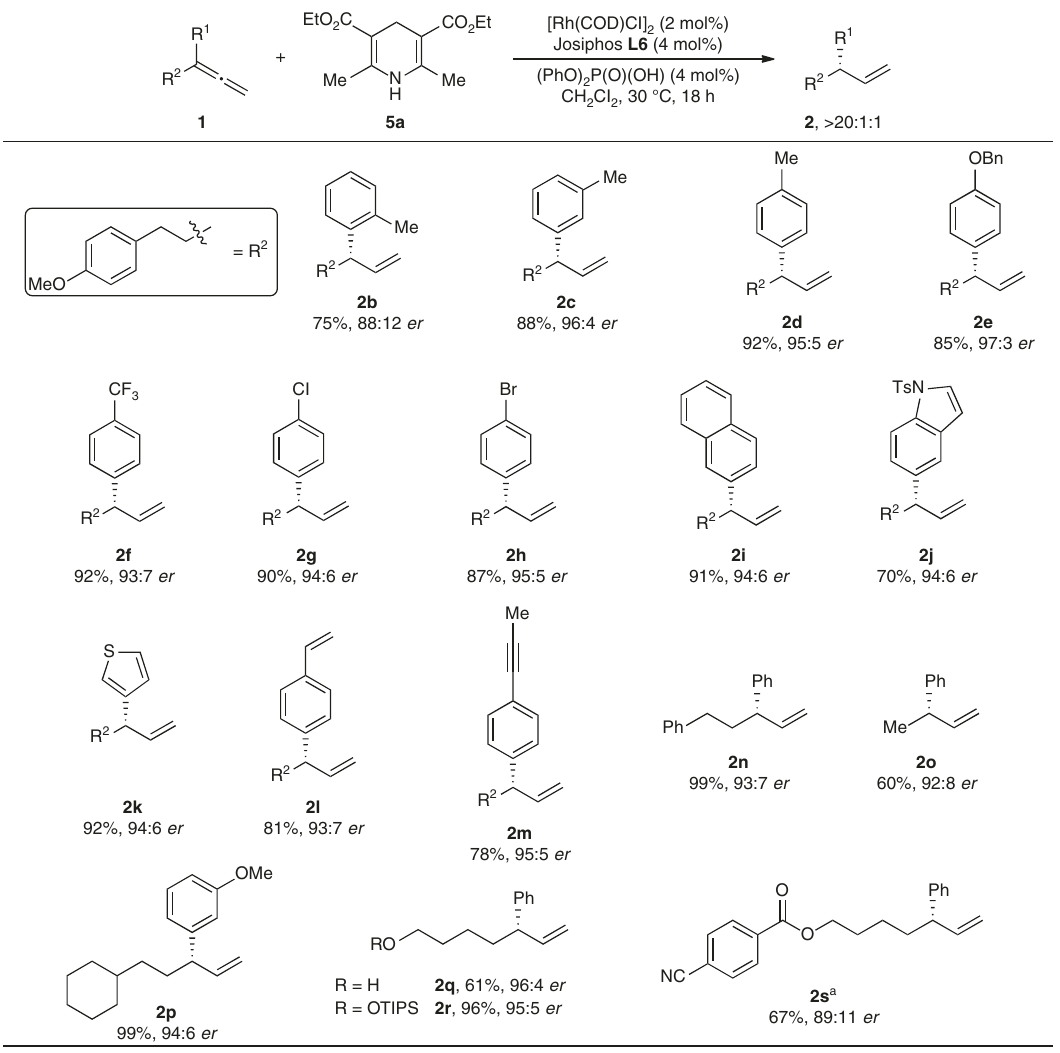
Fig. 4 Enantioselective semireduction of allenes. Reaction conditions: 1 (0.20 mmol), 5a (0.40 mmol), [Rh(COD)Cl] 2 (2 mol%), L6 (4 mol%), (PhO) 2 P(O) (OH) (4 mol%), CH 2 Cl 2 (0.2 mL), 30 °C, 18 h. Isolated yields. Product ratios were determined by 1 H NMR analysis of the unpuri fi ed reaction mixture. Enantioselectivities ( er ’ s) were determined by chiral SFC analysis. a Reaction performed with 1,2-dichloroethane at 60